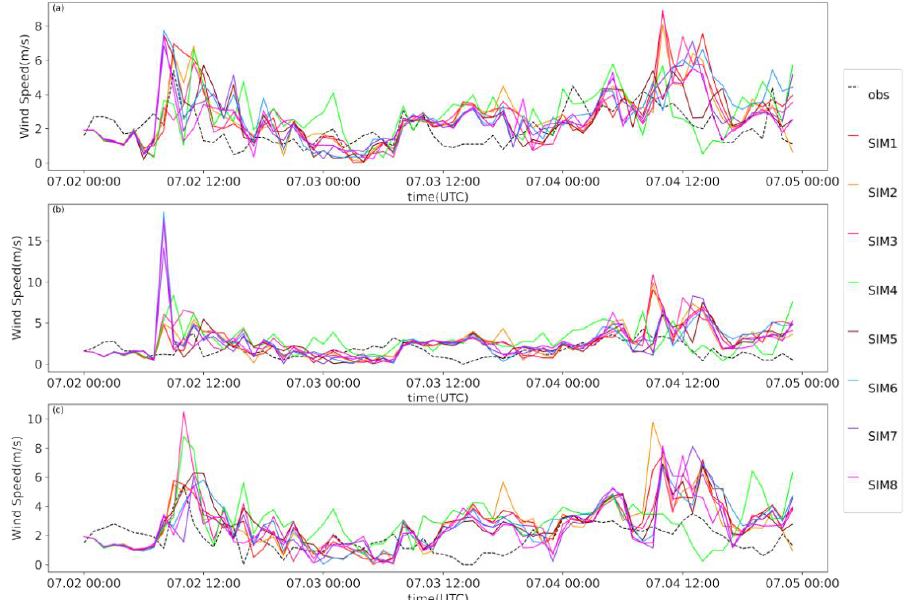
Figure 8. Time series of observed and simulated 10-m wind speeds at 3 sites from 2–4 July at ( a ) Rongcheng: 54,503, ( b ) Xiongxian: 54,636, and ( c ) Anxin: 54,605.